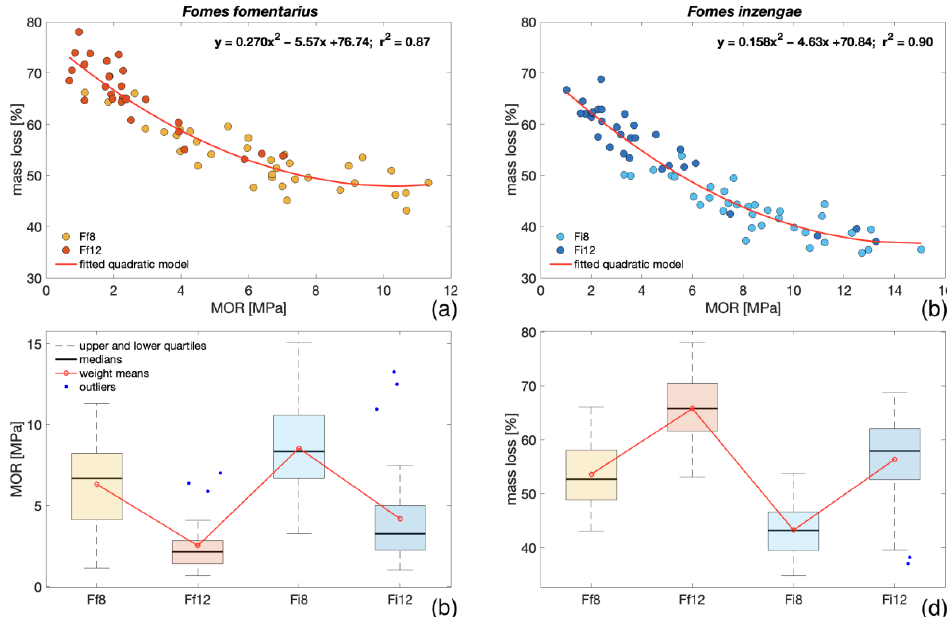
Figure 5. Relationships between 𝑀𝐿 and 𝑀𝑂𝑅 for bending samples degraded by F. fomentarius ( a ) and F. inzengae ( b ), 𝑀𝑂𝑅 ( c ), and 𝑀𝐿 ( d ) of all degraded samples exposed to both species for both exposure periods.